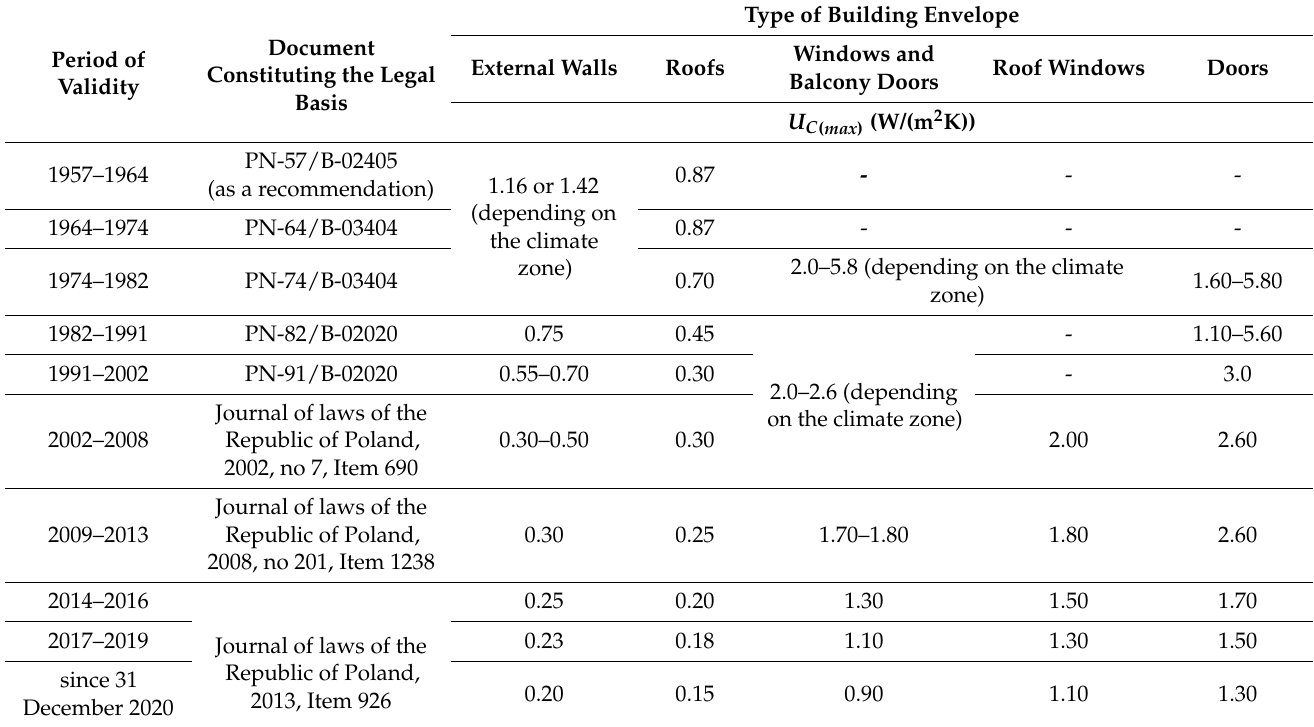
Table 1. Maximum required values of the thermal transmittance coefficient of the selected building envelope at room temperature t i ≥ 16 ◦ C in Poland [2,3].